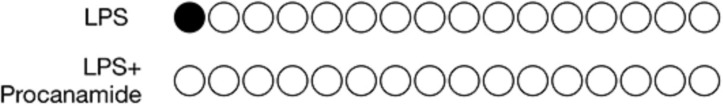
Effects of procainamide on IL27RA methylation in the lung of endotoxemic rat.The 532 bp amplicon corresponds to the rat IL27RA promoter region from -401 to +131 (from the transcription start site of IL27RA). Sixteen CpG dinucleotides within the CpG islands were examined and denoted as open circle (unmethylated) and closed circle (methylated).